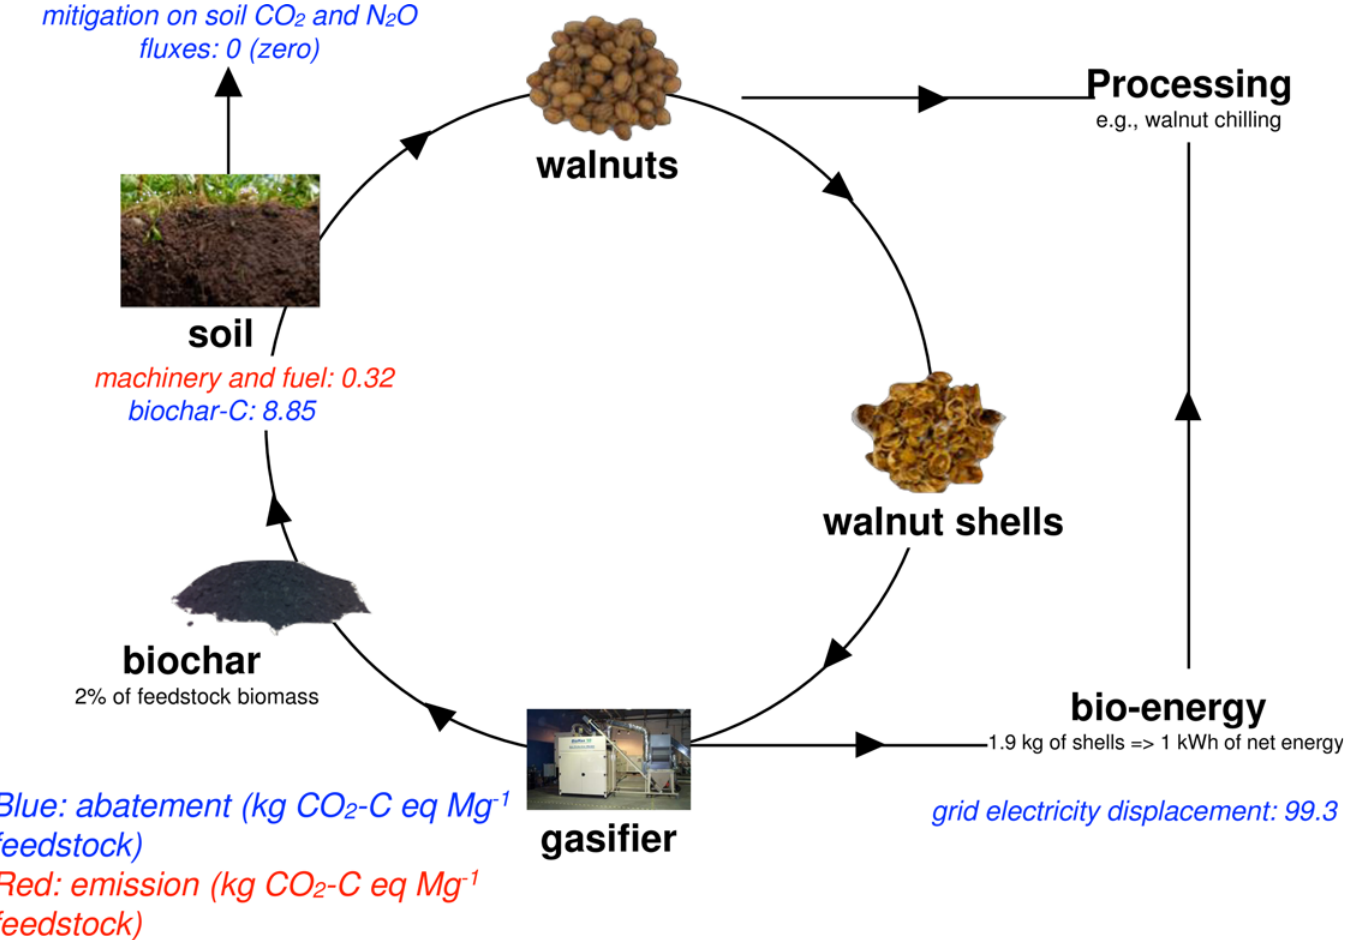
Fig 2. Illustration of the bioenergy-biochar production chain in a walnut farm and processing facility and the CO 2 abatements and emissions associated to these activities.